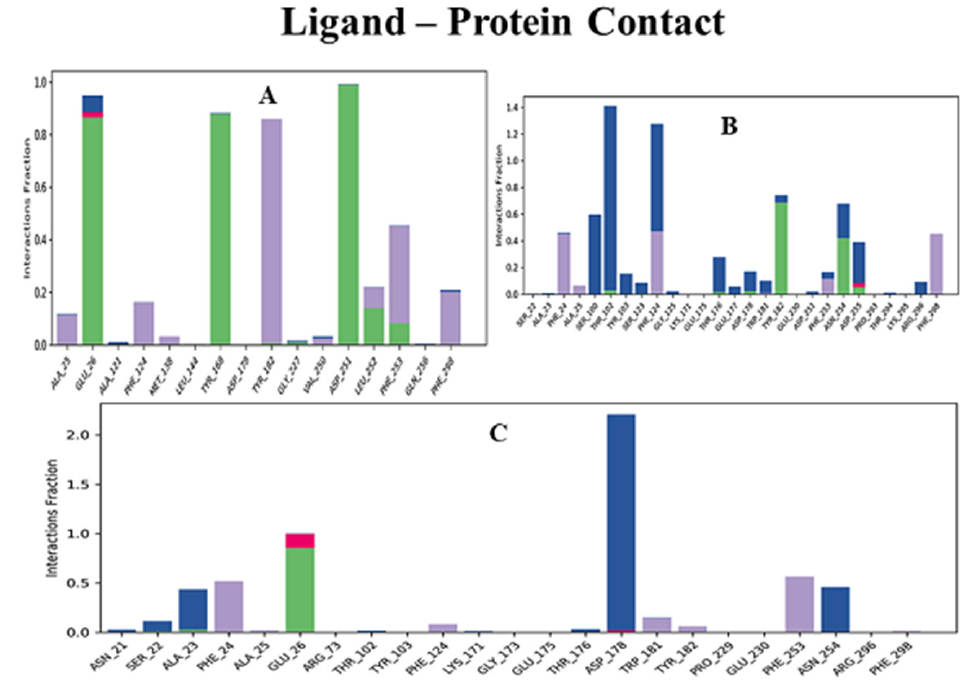
Figure 8. Hydrogen bond contact analysis of lead compounds and ECD GC-C protein complexes. Various intermolecular interactions made by ECD pocket amino acid residues with lead ligands during molecular dynamics simulations. ( A ) Holanamine, ( B ) Holadysenterine, ( C ) Pubescine. Bar colors: Hydrogen bond (Green), Hydrophobic (Purple), Ionic (Red), Water bridge (Blue).